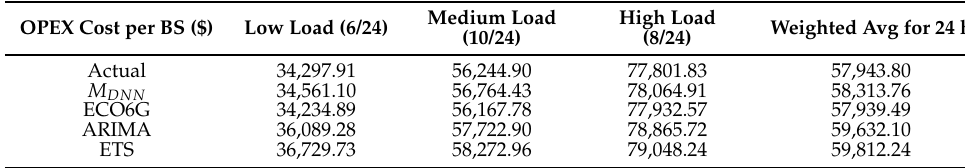
Table 5. OPEX Cost (in $) for MNO to operate ‘a’ BS for 5 years. OPEX Cost per BS